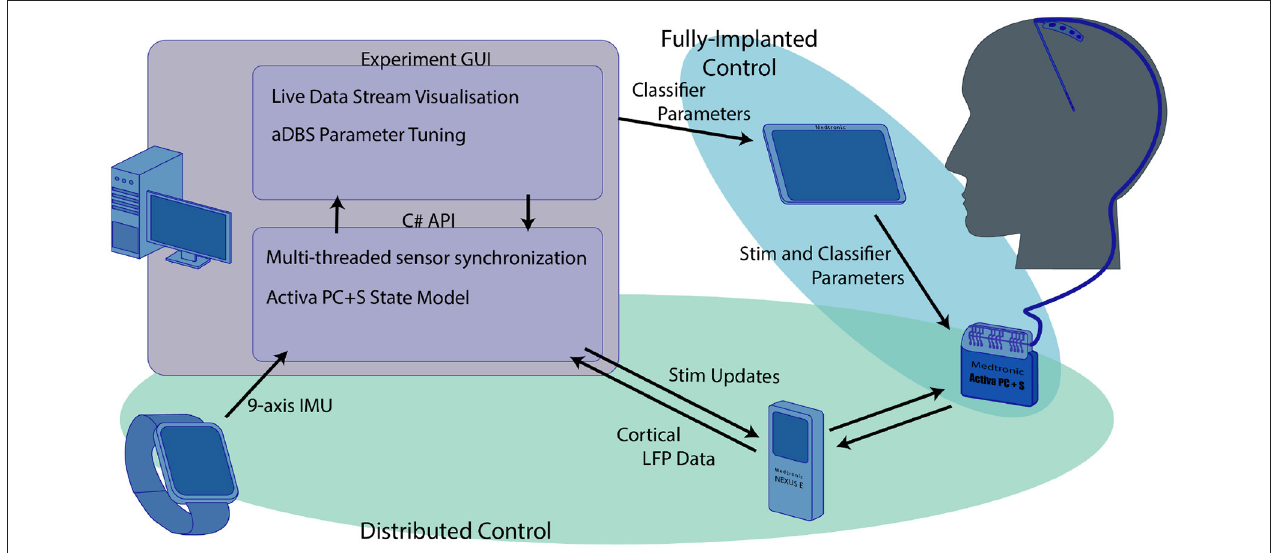
FIGURE 1 | Overview of the research system used for the experiments we describe here. The computer functioned as the central hub that coordinated both the distributed aDBS paradigms and provided a training platform for the fully implanted algorithm. The distributed systems, highlighted in green, used the computer to integrate data from both the smartwatch and real-time cortical LFP streamed through the nexus to drive aDBS stimulation updates. Although the streamed cortical data and IMU smartwatch were used in training the fully implanted classifiers, these classifiers were independent of the main computer once they were transferred to the Activa PC+S using the Medtronic